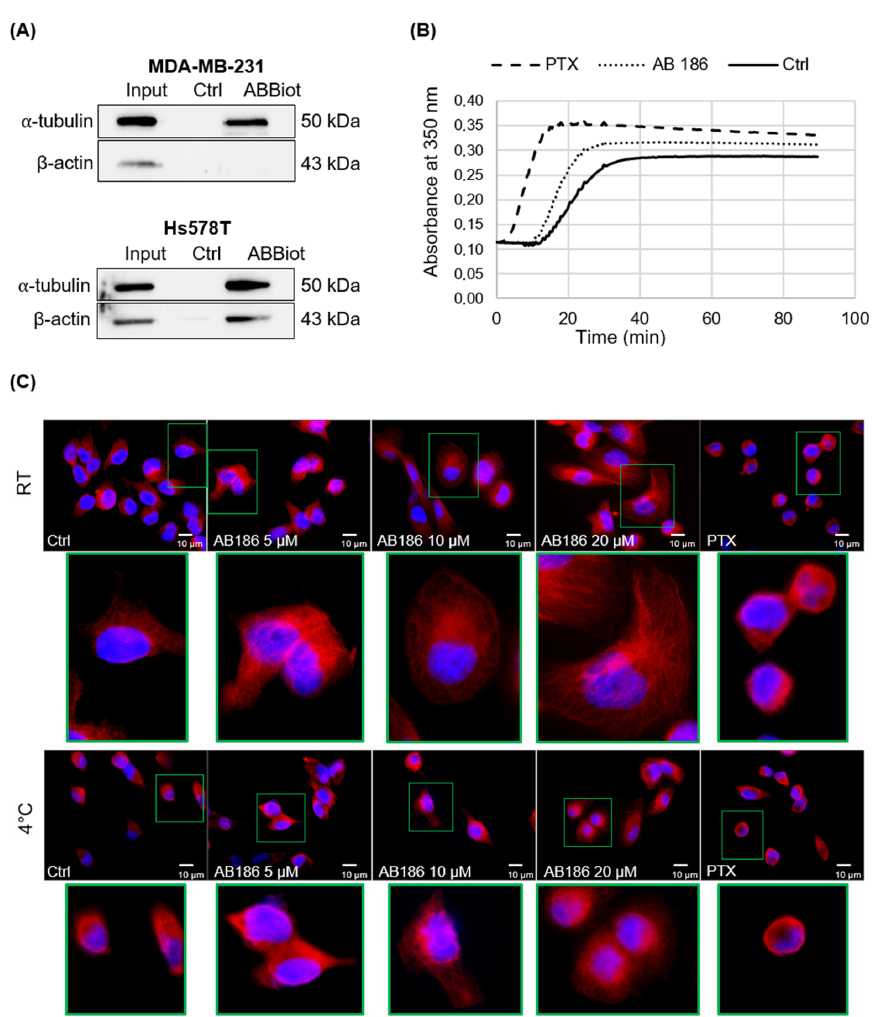
Figure 8. AB186 directly targets the microtubule cytoskeleton. ( A ) MDA-MB-231 and Hs578T